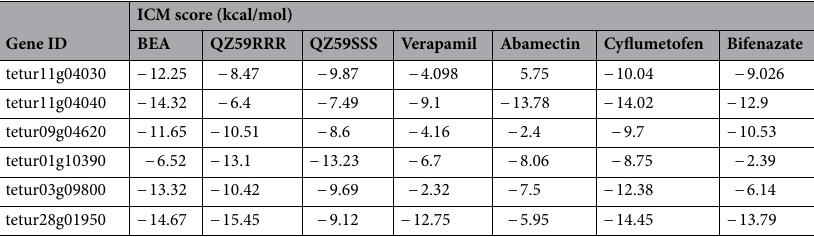
Table 4. ICM score of BEA against ABC transporters implicated in pesticide resistance.